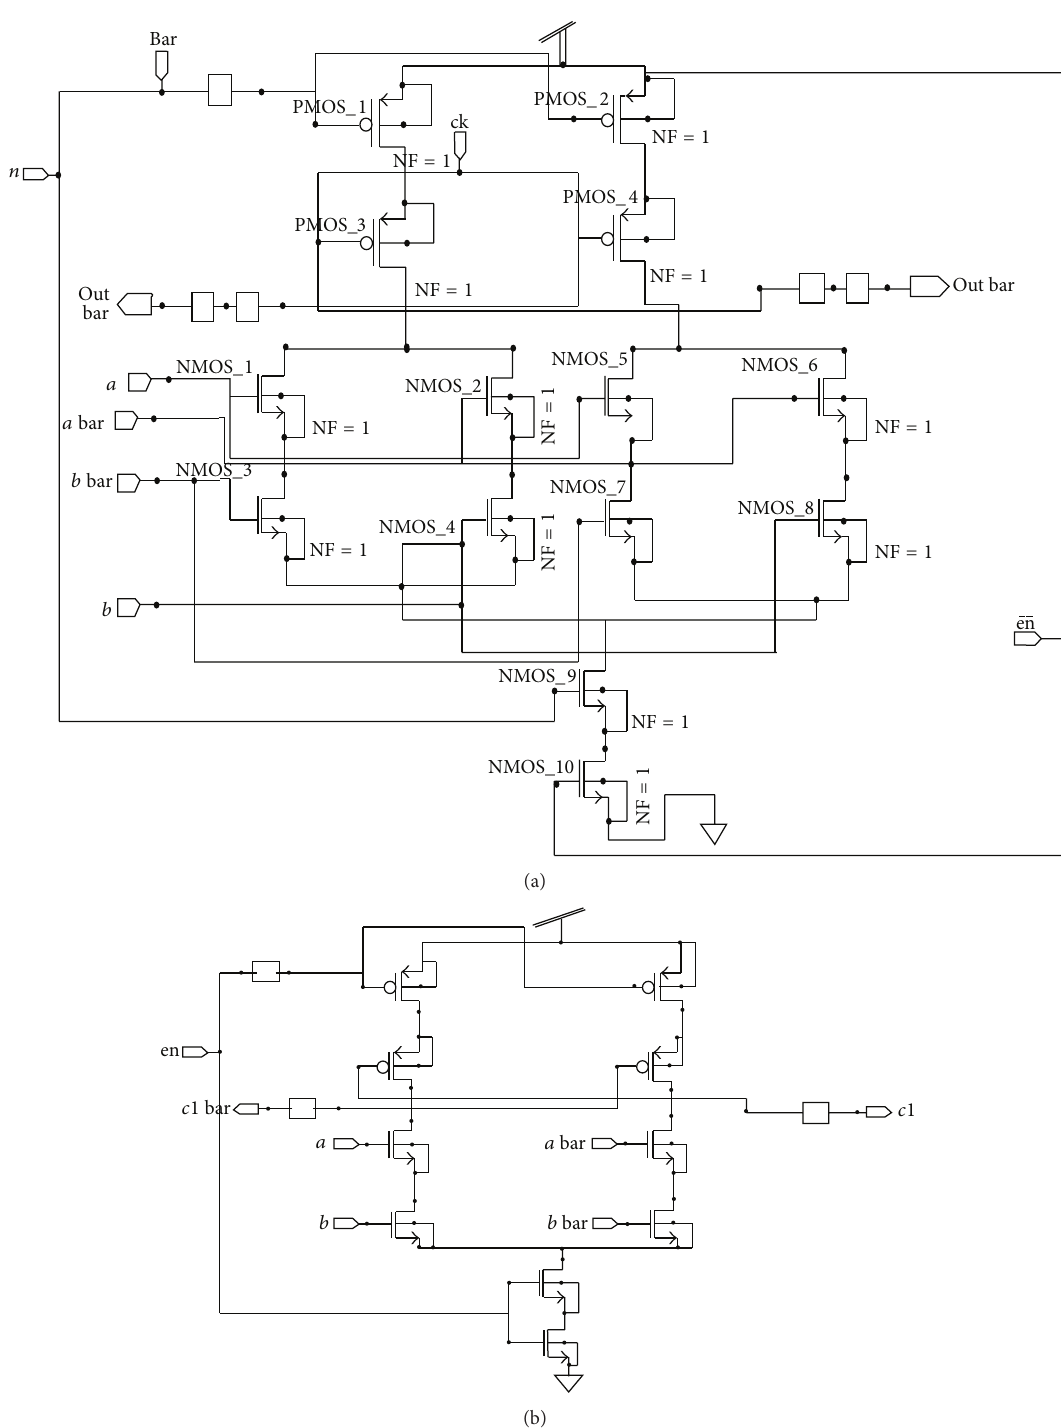
Figure 8: (a) Two-input XOR gates. (b) 2-input AND